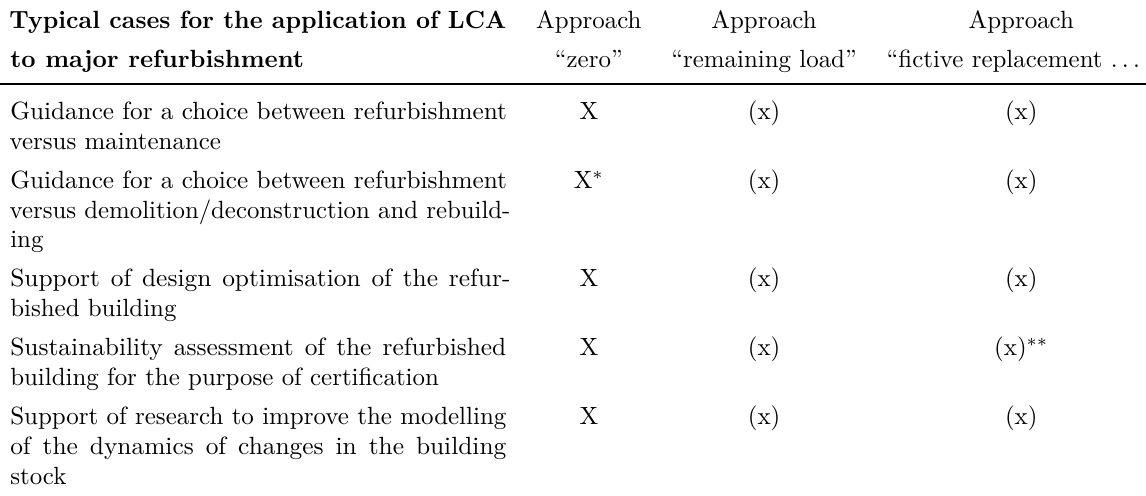
Table 3. Suitability of approaches for different typical decision-making